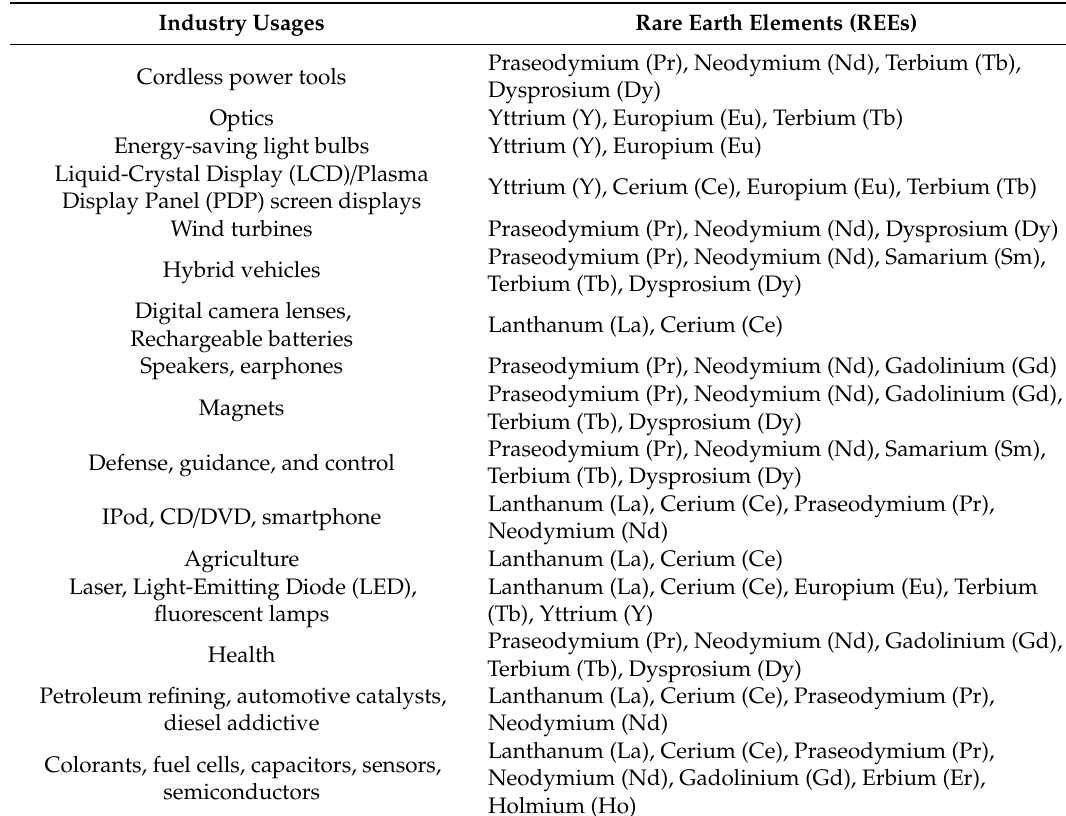
Table 1. Summary of the industry usage of rare earth elements